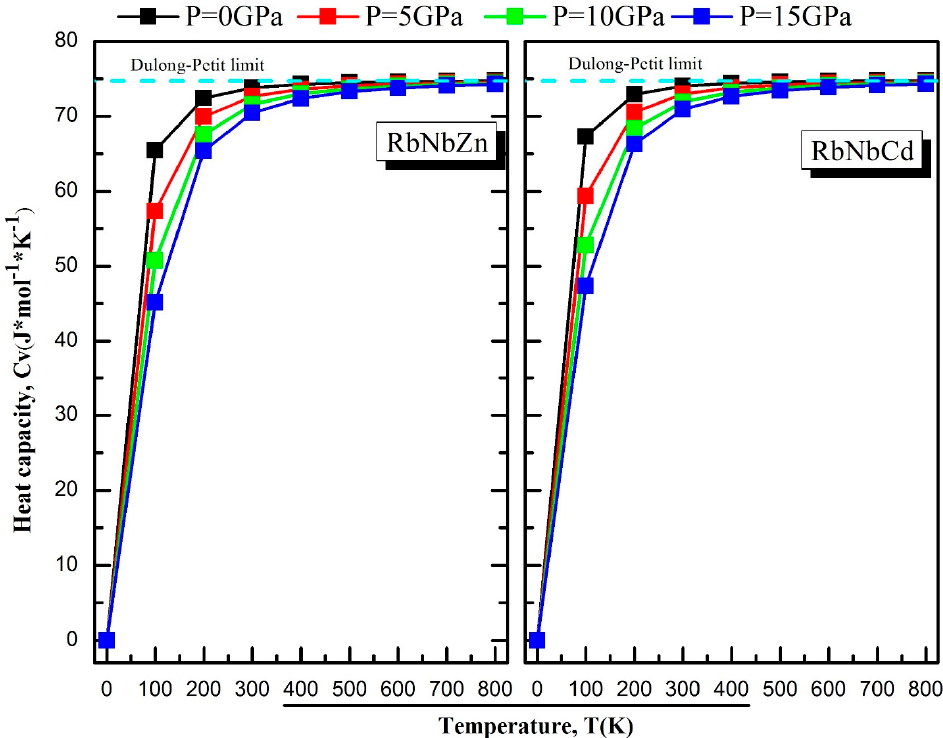
Figure 8. The heat capacity (C v ) as a function of temperature at different pressures for RbNbCd and RbNbZn.